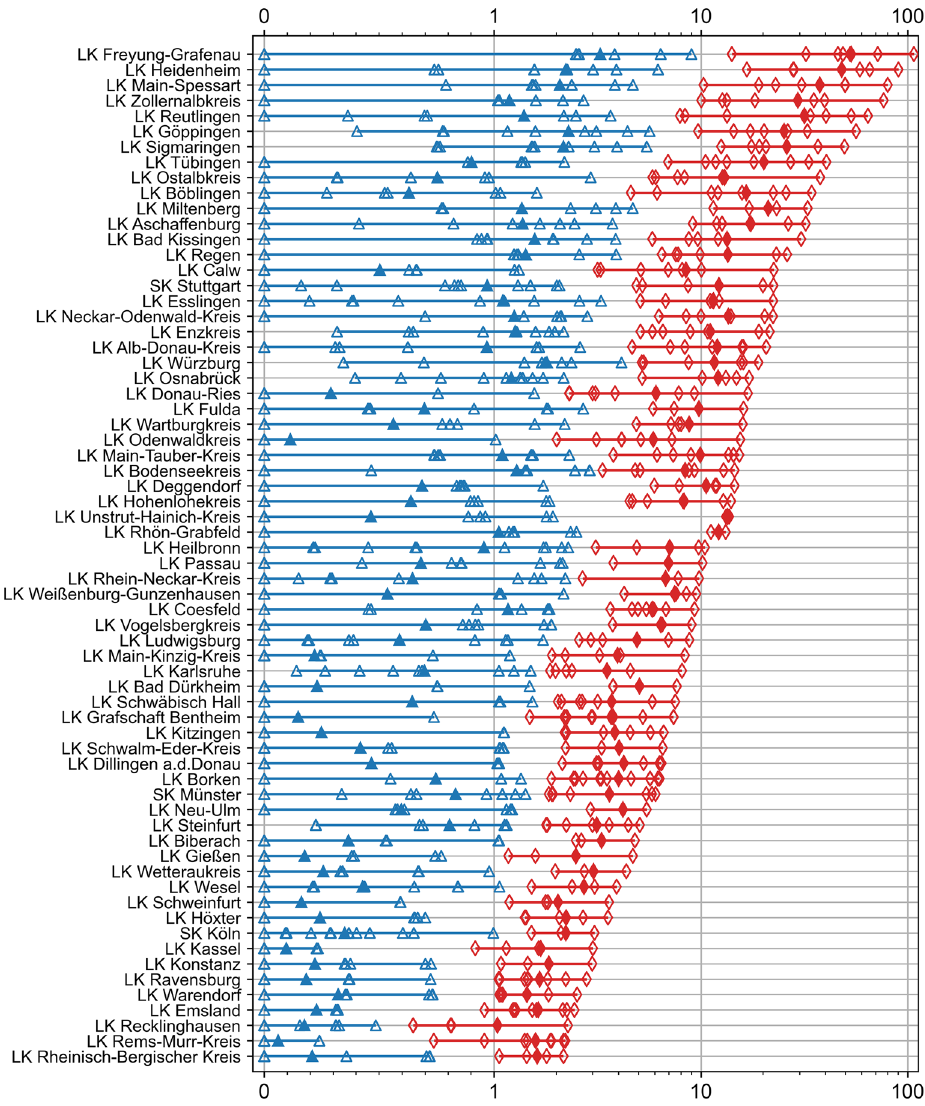
Figure 2. The annual incidence values in the selected districts from 2006 to 2021. The 66 districts are ordered by the maximum annual incidence. The low-risk bin is indicated by blue triangles (on the left side of the plot). The high-risk bin is indicated by red diamonds (on the right side of the plot). The filled triangles and diamonds indicate the average value for each bin. The solid lines highlight the incidence range for each bin. The white gaps between the blue and the red lines indicate the separation between the two bins for each district. The x-axis is linear in the range [0, 1] and log-scaled in [1, 110] for increased visibility. The naming convention matches that of the German version of SurvStat@RKI 2.0. LK: rural district (from the German Landkreis ) and SK: urban district (from the German Stadtkreis